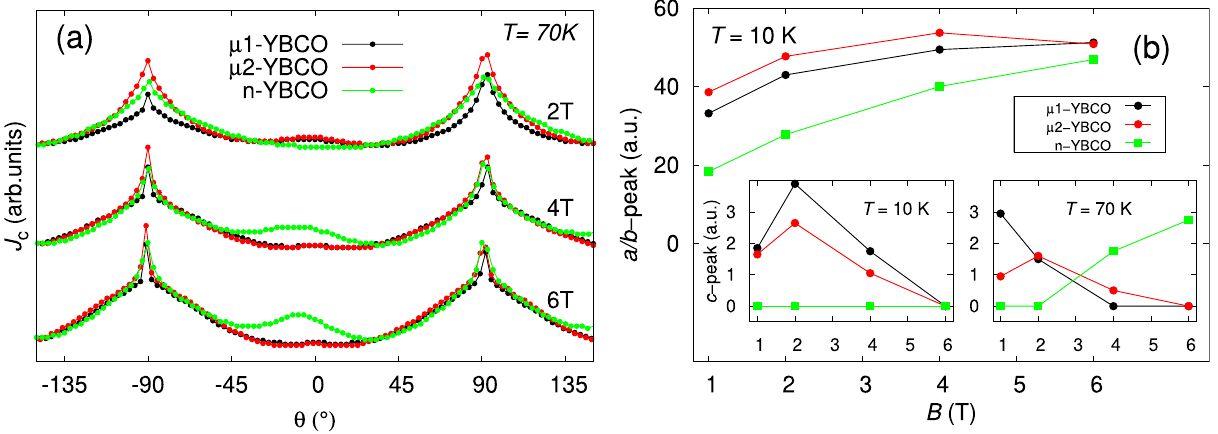
Figure 5. ( a ) The angular dependencies of J c measured at 70 K and in 2 T, 4 T and 6 T magnetic fields for µ 1-, µ 2- and n-YBCO films. The angles θ = − 90 ◦ and 90 ◦ correspond to the ab -plane and θ = 0 ◦ the YBCO c -axis. The curves are shifted in y-direction for detailed shape comparison. ( b ) The relative heights of the ab -peaks (the main panel) and c -peaks (insets) as the functions of the applied magnetic field in µ 1-, µ 2- and n-YBCO